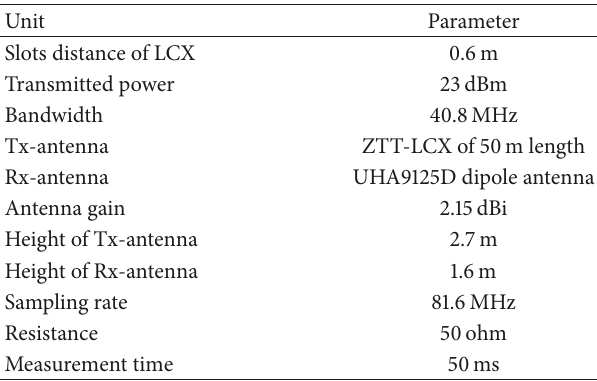
Table 1: Measuring